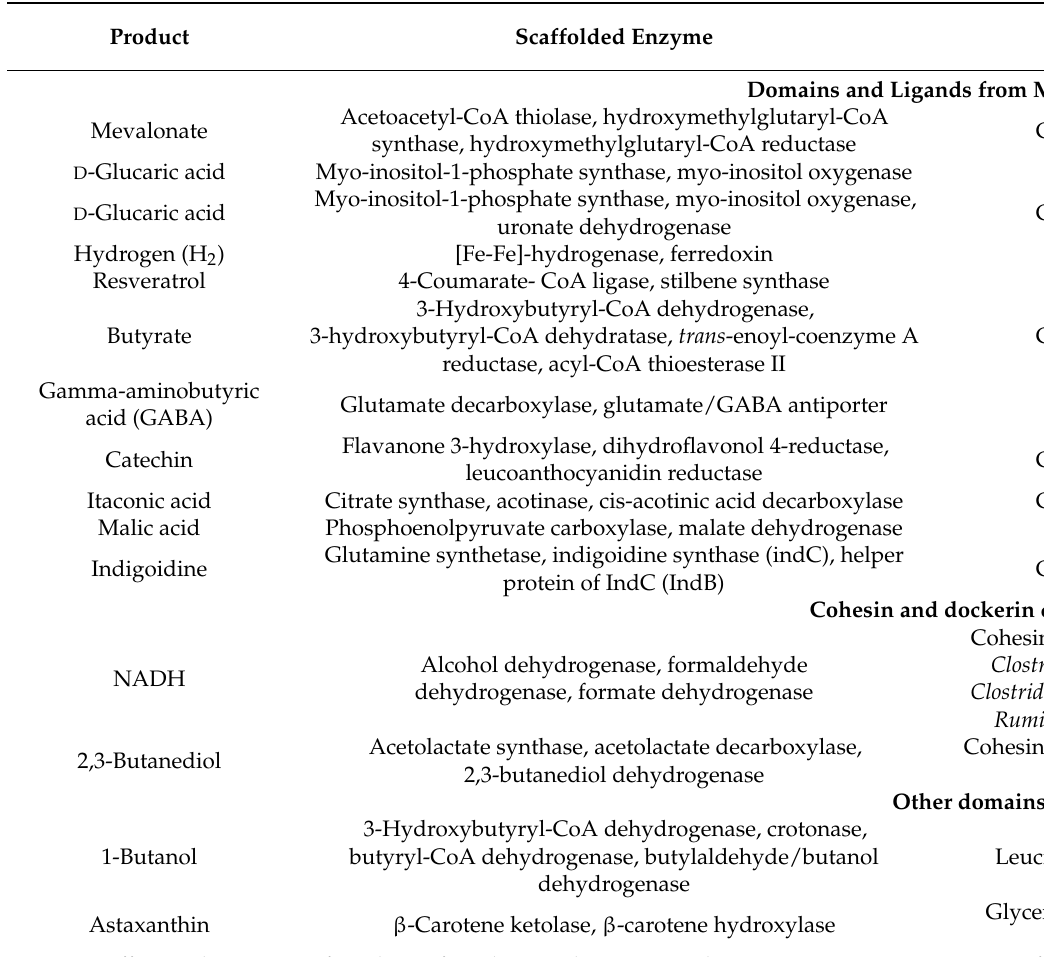
Table 1. Examples of protein scaffold